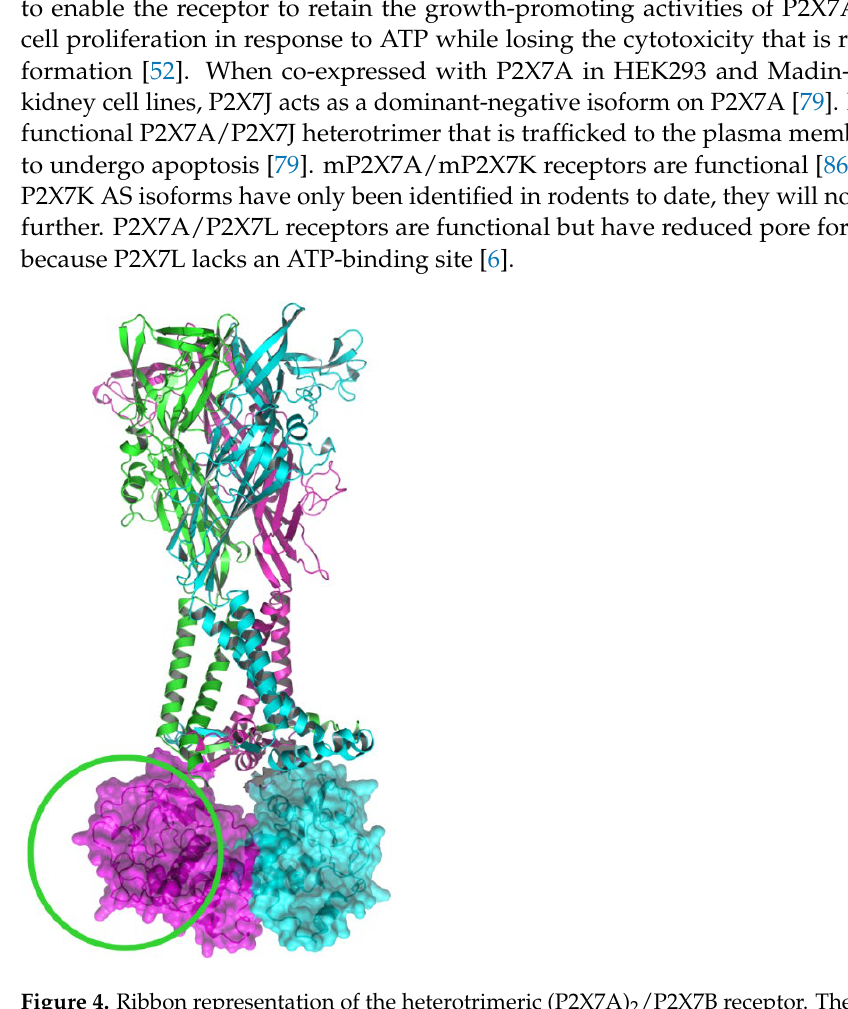
Figure 4. Ribbon representation of the heterotrimeric (P2X7A) 2 /P2X7B receptor. The P2X7B subunit is shown in green, lacking the carboxy terminal as highlighted by the green circle, while the P2X7A subunits are shown in pink and blue. Molecular surface representations of the P2X7A carboxy termini are shown in pink and blue. The structural model has been produced using PyMOL software version 2.5.2 [23].